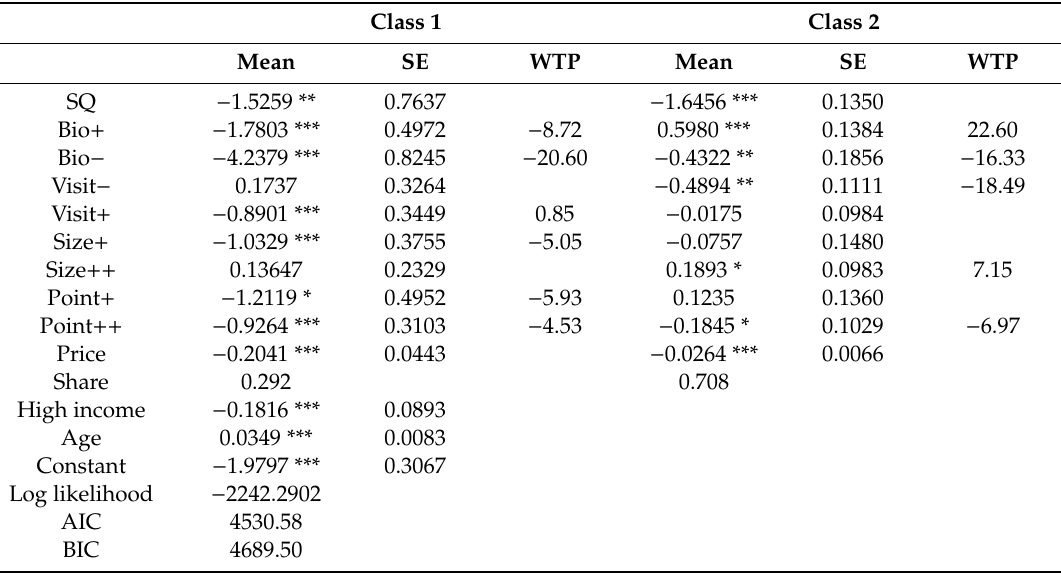
Table 7. Latent class choice